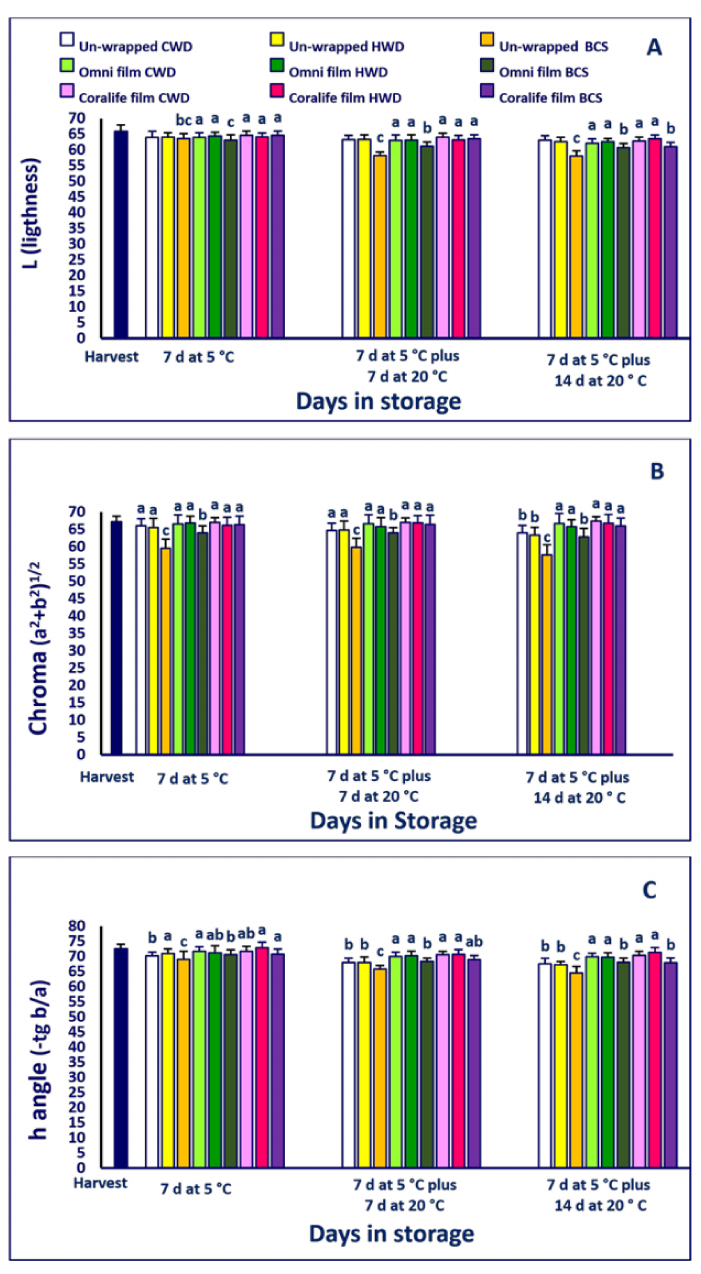
Figure 5. Peel color components L* ( A ), chroma ( B ), and hue ( C ) of ‘Simeto’ mandarins as affected by fungicidal treatment and packaging. For each storage time, means separation was accomplished by Duncan’s multiple range test. Means followed by different letters are significantly different at p < 0.05. Vertical bars indicate the standard deviation (n =